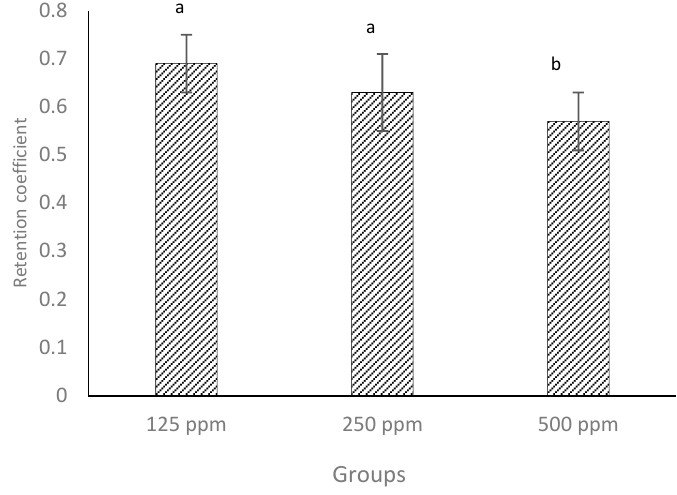
Figure 4. Retention coefficients of three different concentrations of free (+)-catechin in full-fat cheeses measured by HPLC. Columns with different superscript letters differ significantly at p ≤ 0.05.